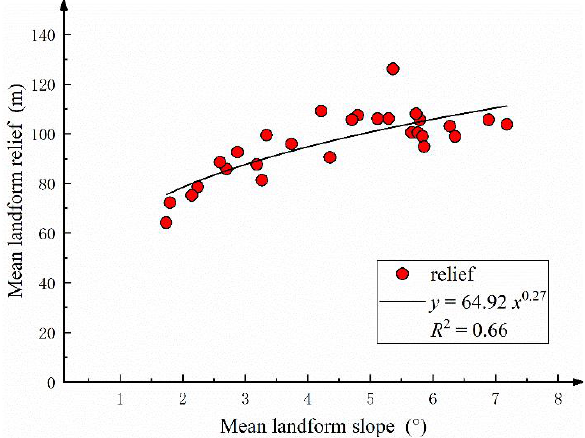
Figure 8. Relationship between relief and